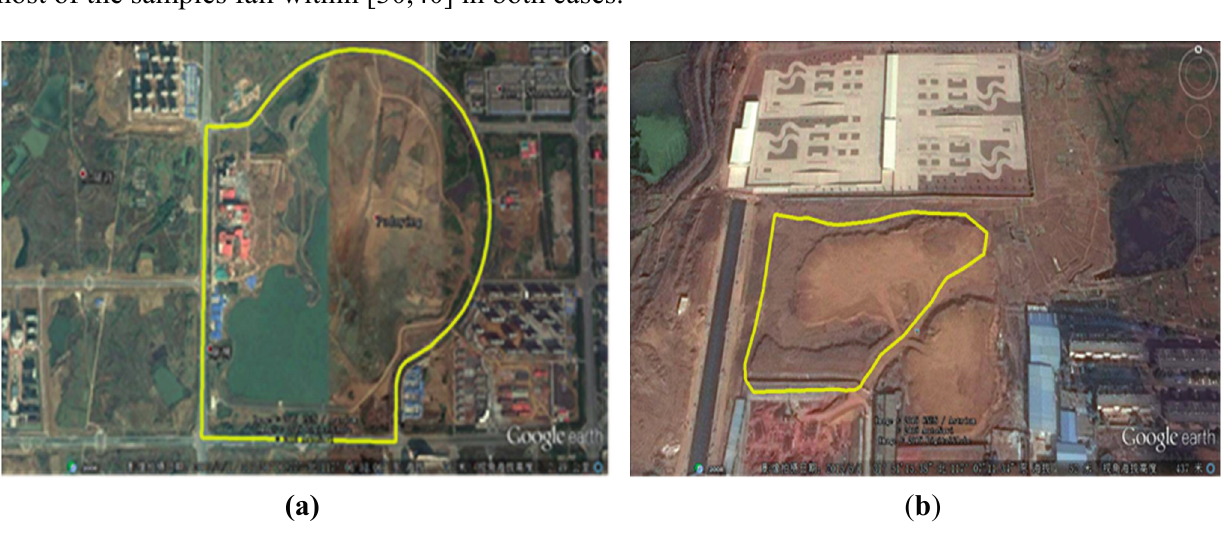
Figure 12. Satellite aerial photographs of the urban scene ( a ) and the rural scene ( b ).